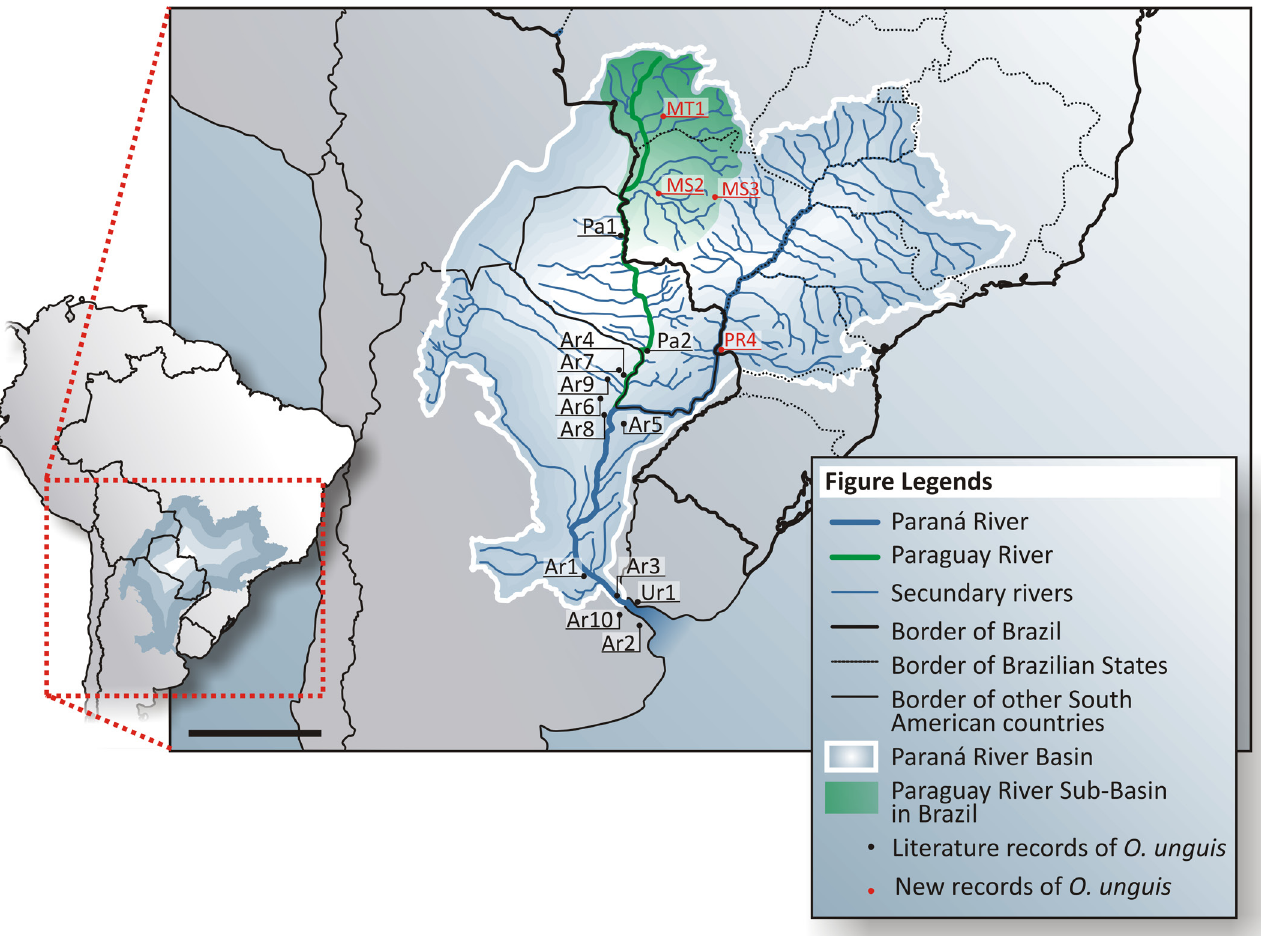
Figure 3. Omalonyx unguis Occureces of in South America. The black dots represent previously known as reported by Hylton-Scott and Lapuente (1968) and Arruda and Thomé (2008) and the red dots represent new Brazilian records. Ar = Argentina (Ar1 = Rosario; Ar2 = Rio Santiago, La Plata; Ar3 = Barca Grande, Delta Del Paraná; Ar4 = Guaycolec; Ar5 = Manantiales; Ar6 = Rio de Oro; Ar7 = Formosa; Ar8 = Resistência; Ar9 = Villafañe; Ar10 = Partido de Tigre); MS = Mato Grosso do Sul, Brazil (MS1 = Miranda; MS2 = Campo Grande); MT1 = Poconé, Mato Grosso, Brazil; PA = Paraguay (Pa1 = Puerto Guarani; Pa2 = Asunción); PR1 = Foz do Iguaçu, Paraná, Brazil; Ur1 = Colonia, Uruguay. Scale bar = 1000